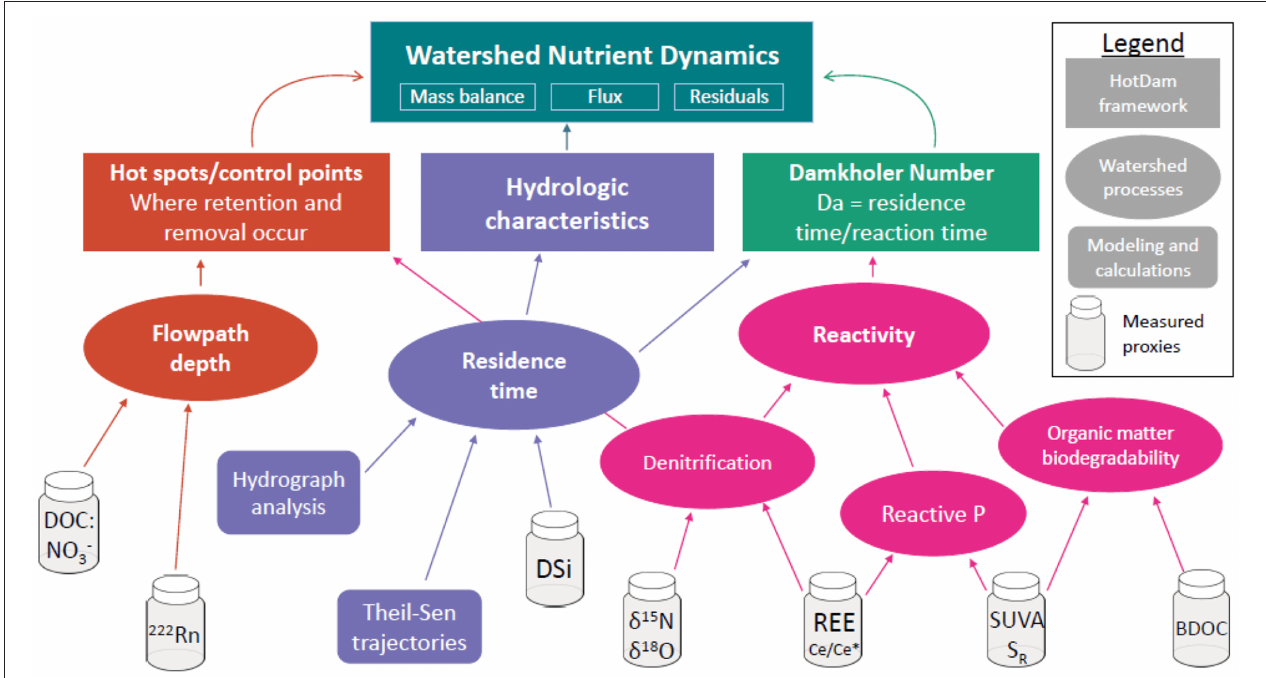
FIGURE 1 | Conceptual diagram of the crossed-proxy approach we used to investigate controls on watershed-scale nutrient attenuation. We hypothesized that watershed-scale nutrient attenuation was a function of water flowpath (red), residence time (purple), and biogeochemical reactivity